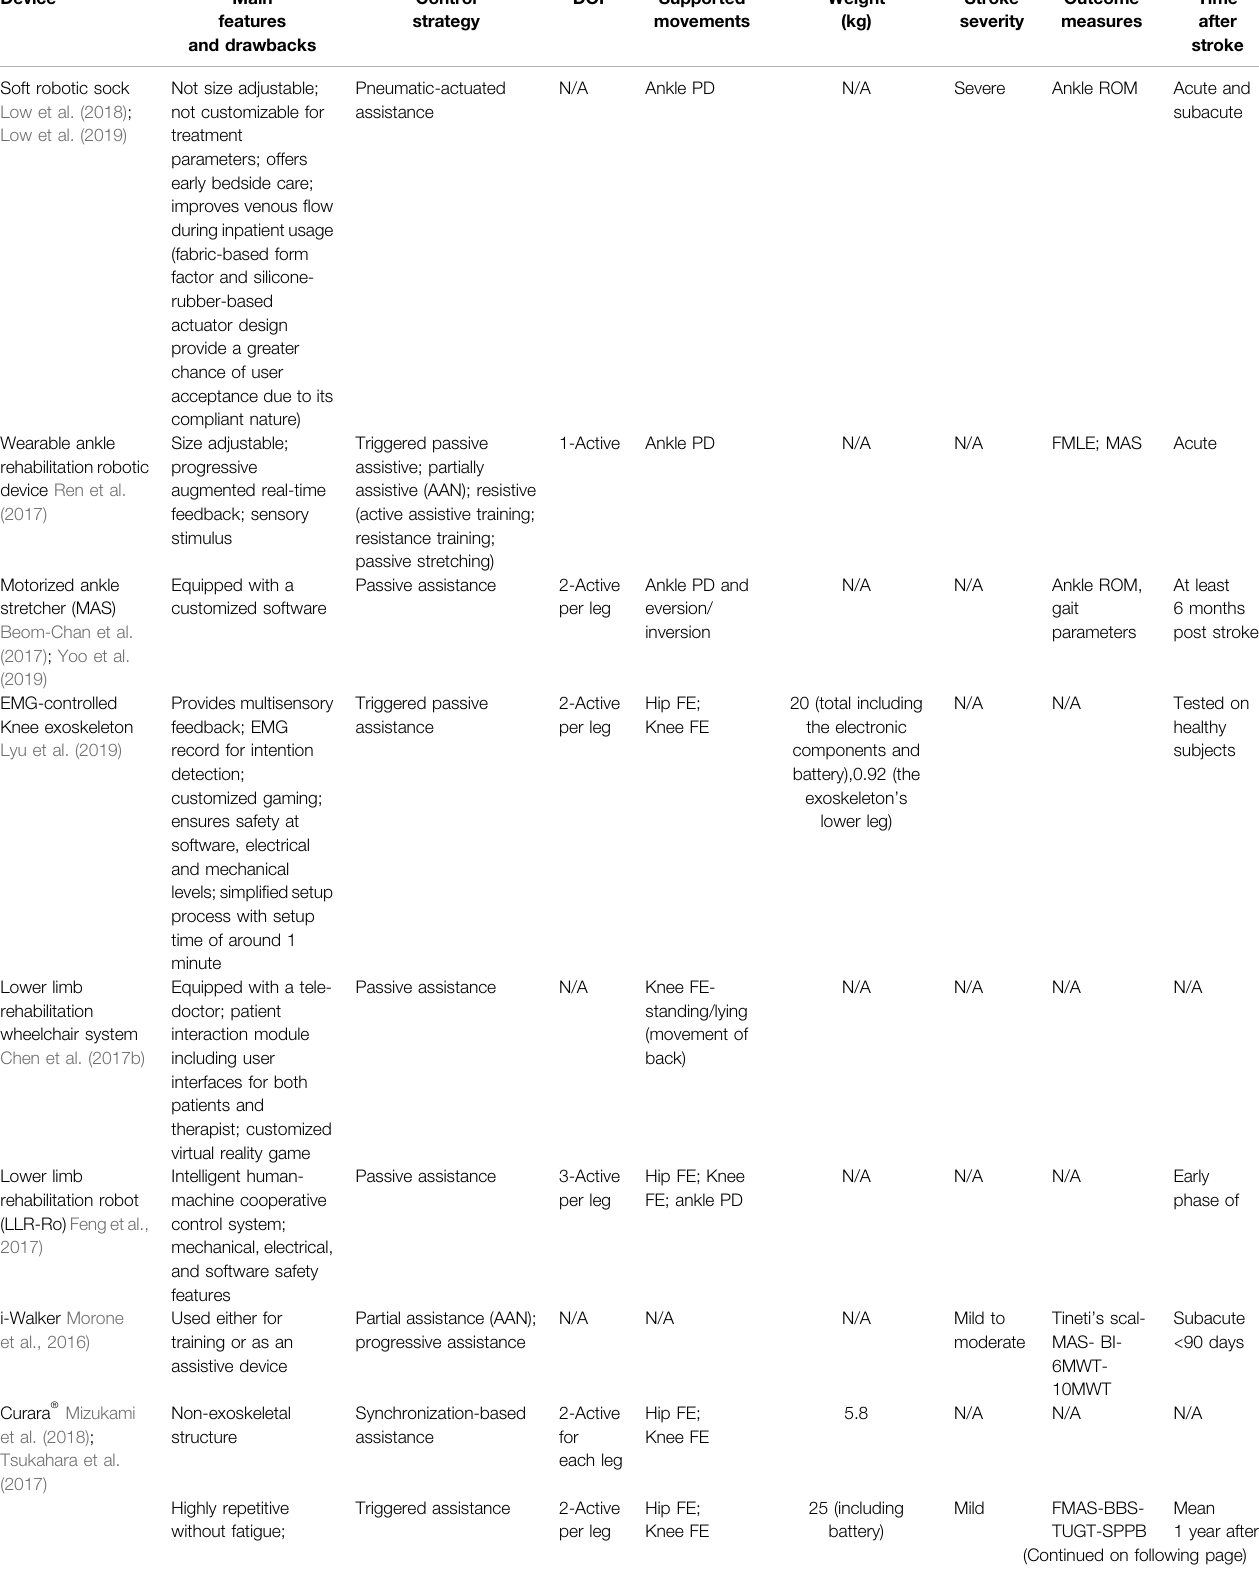
TABLE 3 | Summary of state-of-the-art robotic systems for home-based lower-limb rehabilitation.